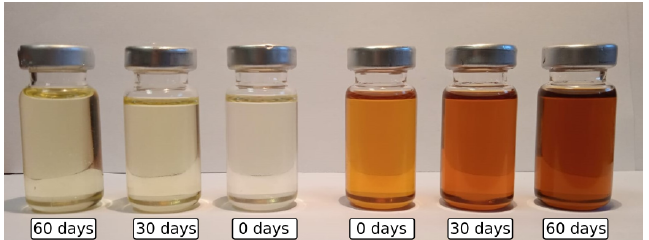
Figure 2. NF and NE aged fluid at several points of the accelerated aging